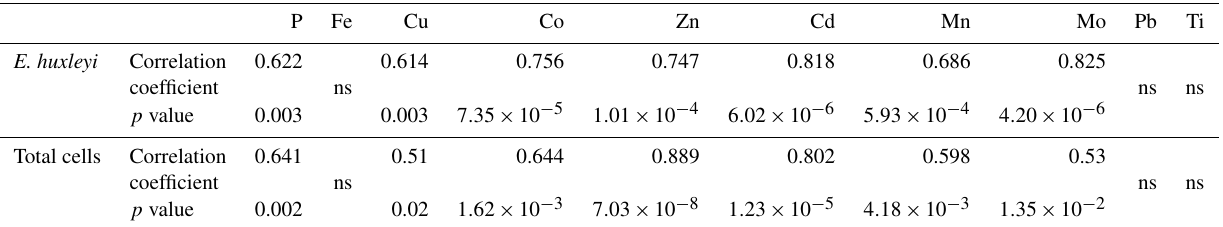
Table 4. The relationship (Pearson correlations, p < 0 . 05) between particulate metal concentrations (nmolL − 1 , no oxalate wash, reported in Table S2) and the biomass (µgCL − 1 ) of Emiliania huxleyi and total cells (phytoplankton and microzooplankton) collected from the different mesocosm treatments.